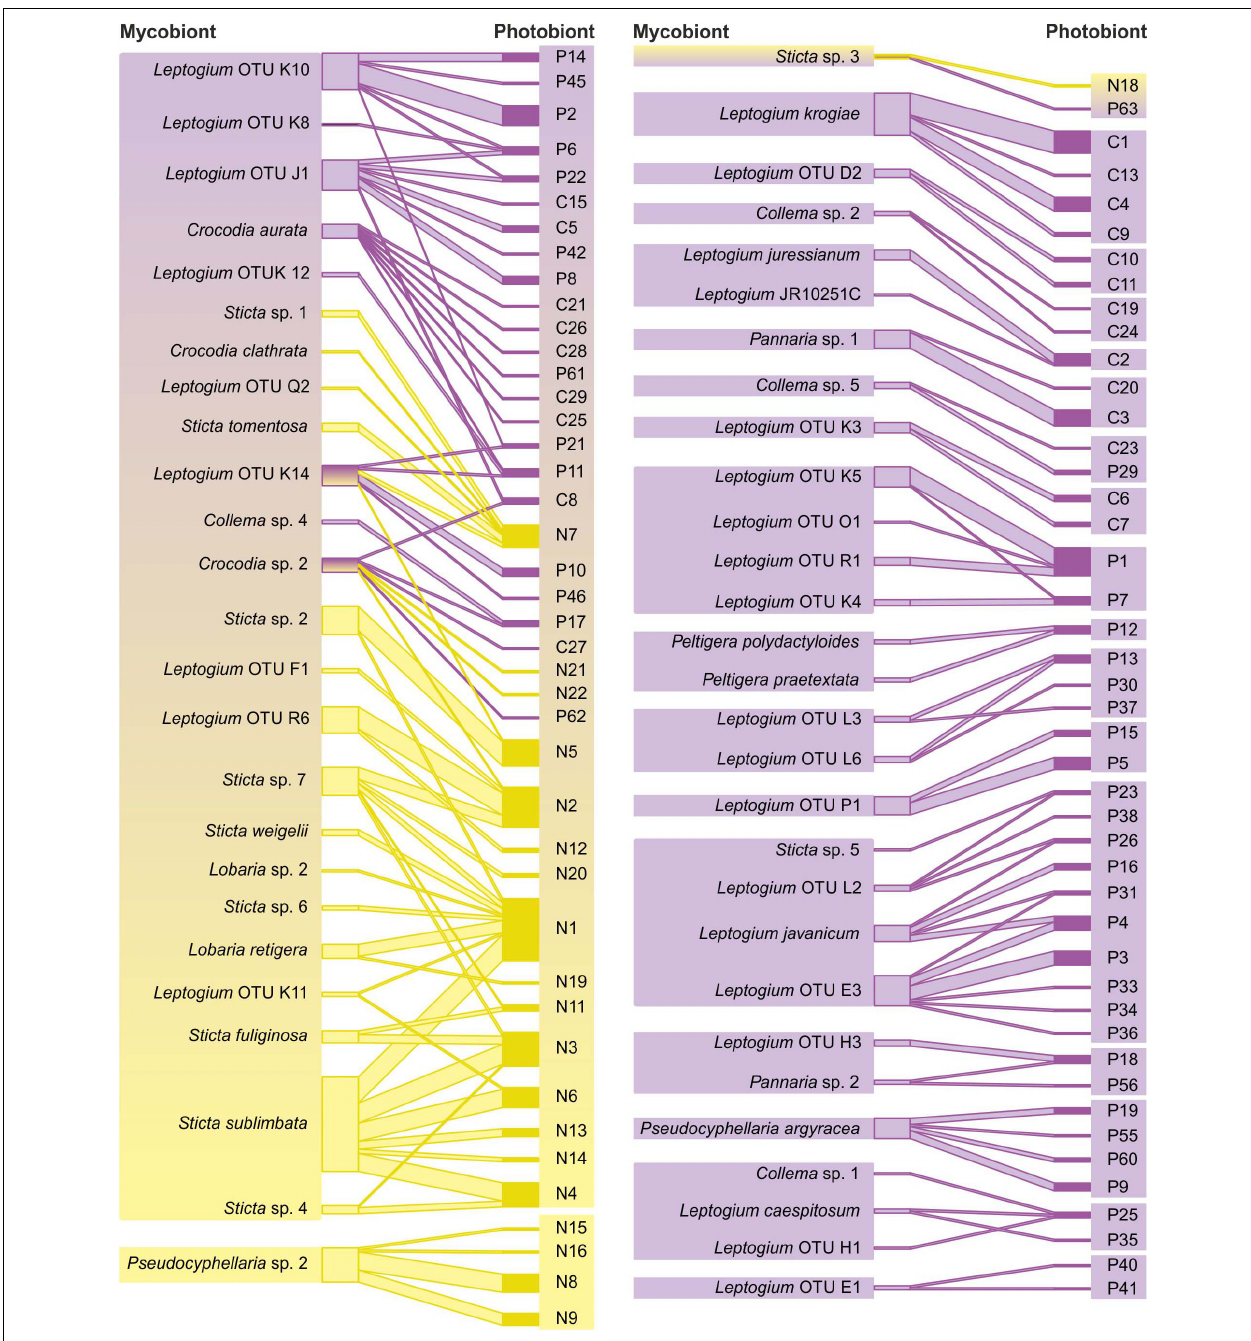
FIGURE 2 | Mycobiont–photobiont associations among analyzed cyanolichens, excluding the 20 mycobiont–cyanobiont pairs that associated exclusively with one another. Mycobiont taxa on the left and cyanobiont variants on the right, yellow showing Nephroma guild lichens with Nephroma -type Nostoc variants, and purple indicating Peltigera guild lichens with Collema / Peltigera -type Nostoc variants. The line thickness between specific fungal species and cyanobiont variants is proportional to in how many different lichen specimens the interaction was detected.